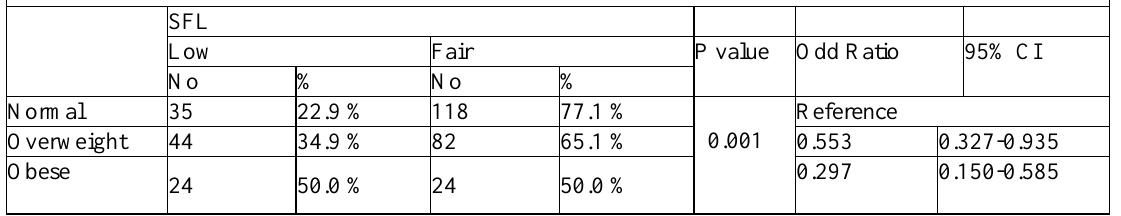
Table 2. Distribution of patients according to weight status (BMI) and its association with